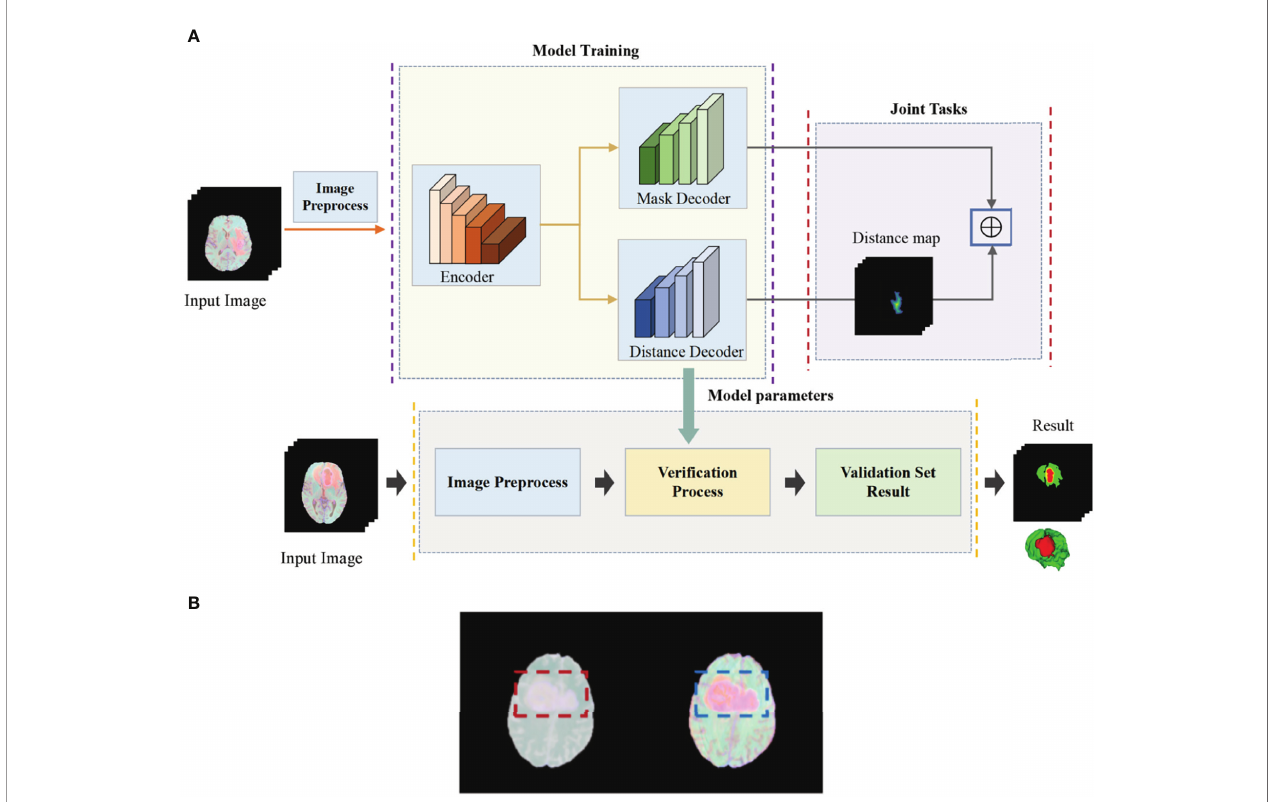
FIGURE 1 | (A) Flow chart of our deep multi-task learning framework for brain tumor segmentation. (B) Brain tumor images before and after the